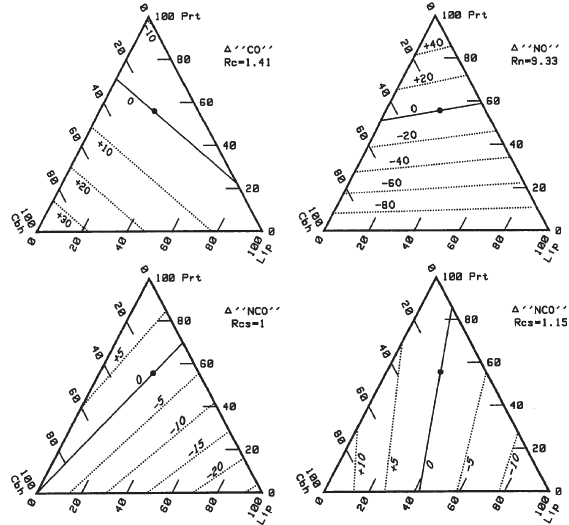
F IG . 6.- Oxygen errors (in percentage of moles) when is calculated from the synthesis or oxidation of particulate organic matter of dif- ferent biochemical composition and by using “CO”, “NO” and “NCO”. Carbon proportion of the three main groups of biomole- cules (carbohydrates, lipids and proteins) are indicated on each side of the triangles. The point inside the triangles represents the modified Redfield composition according to Anderson (1995) and Fraga et al.